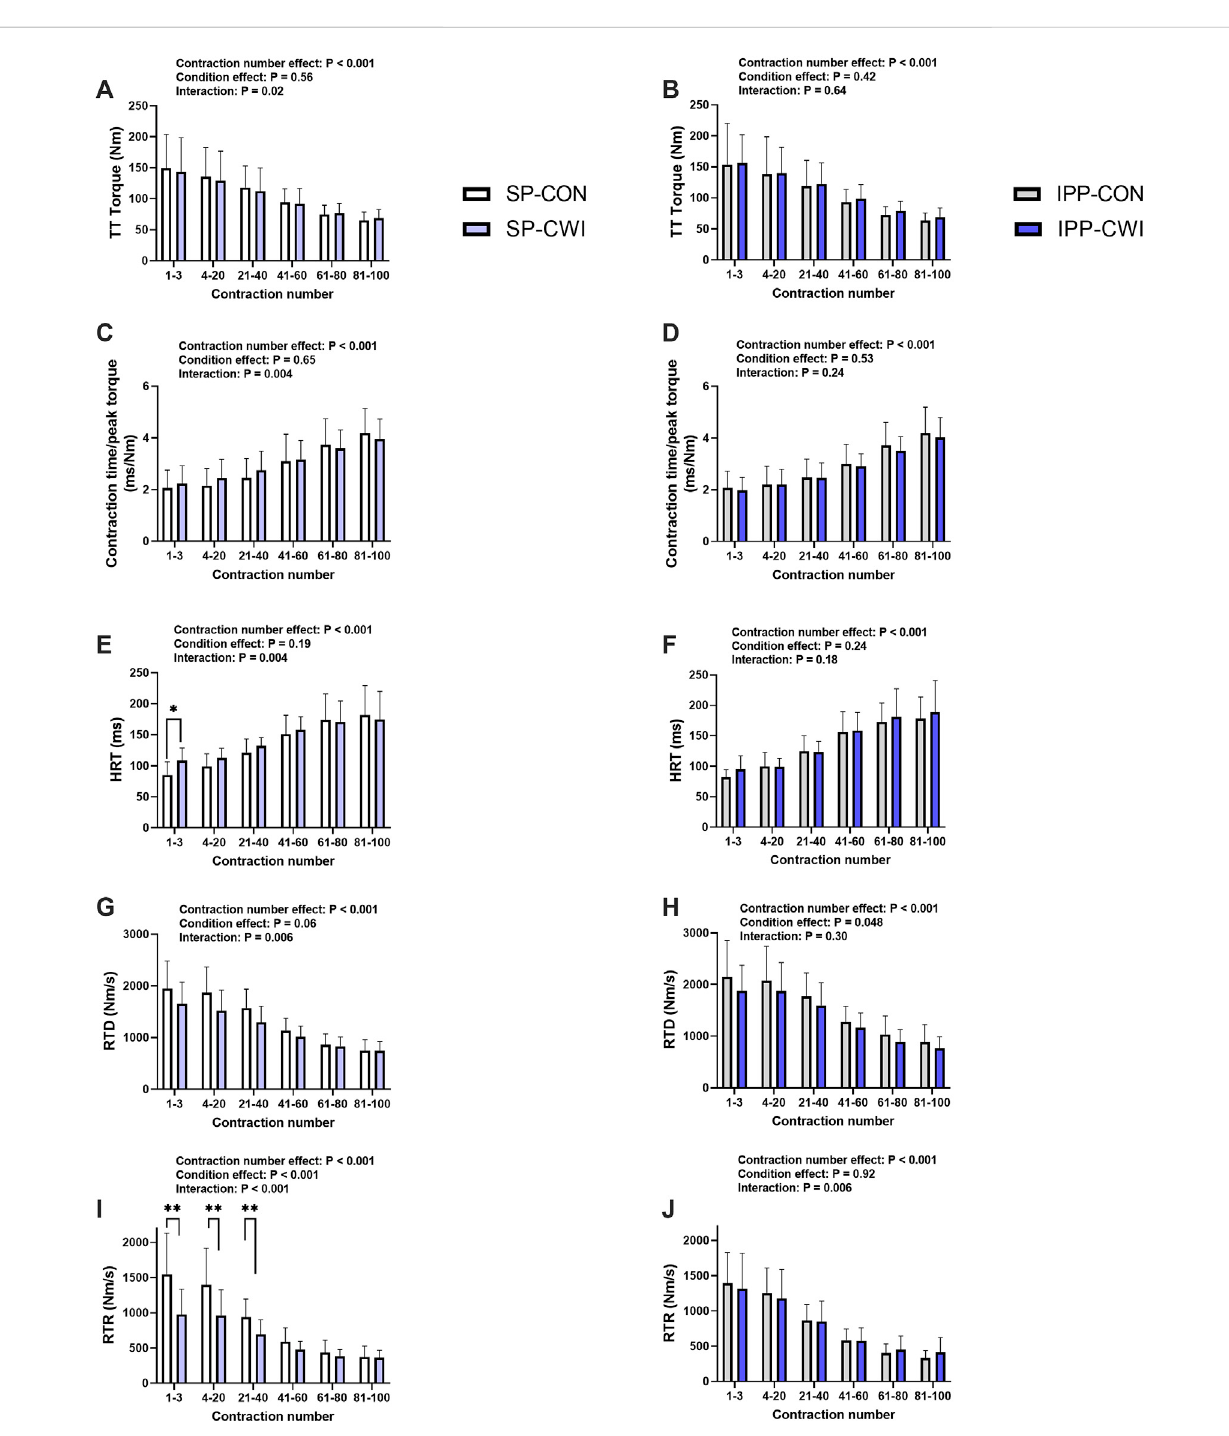
FIGURE 6 Torques and contractile properties during the fatiguing protocol. Torques during 250-ms test train stimulations at 100 Hz (TT torques) (A,B) , contraction time/peak torque (C,D) , half-relaxation time (HRT) (E,F) , peak rate of torque development (RTD) (G,H) , and peak rate of torque relaxation (RTR) (I,J) during thesingle and intermittent/prolonged phases, respectively. Data are shown asmean ± SD.SP,single phase; IPP, intermittent/prolonged phase. *, p < 0.05; **, p < 0.01: Signi fi cant differences CON vs. CWI. N = 12 for all parameters except for RTD (N = 10) (G,H) and RTR (N = 10) (I,J)